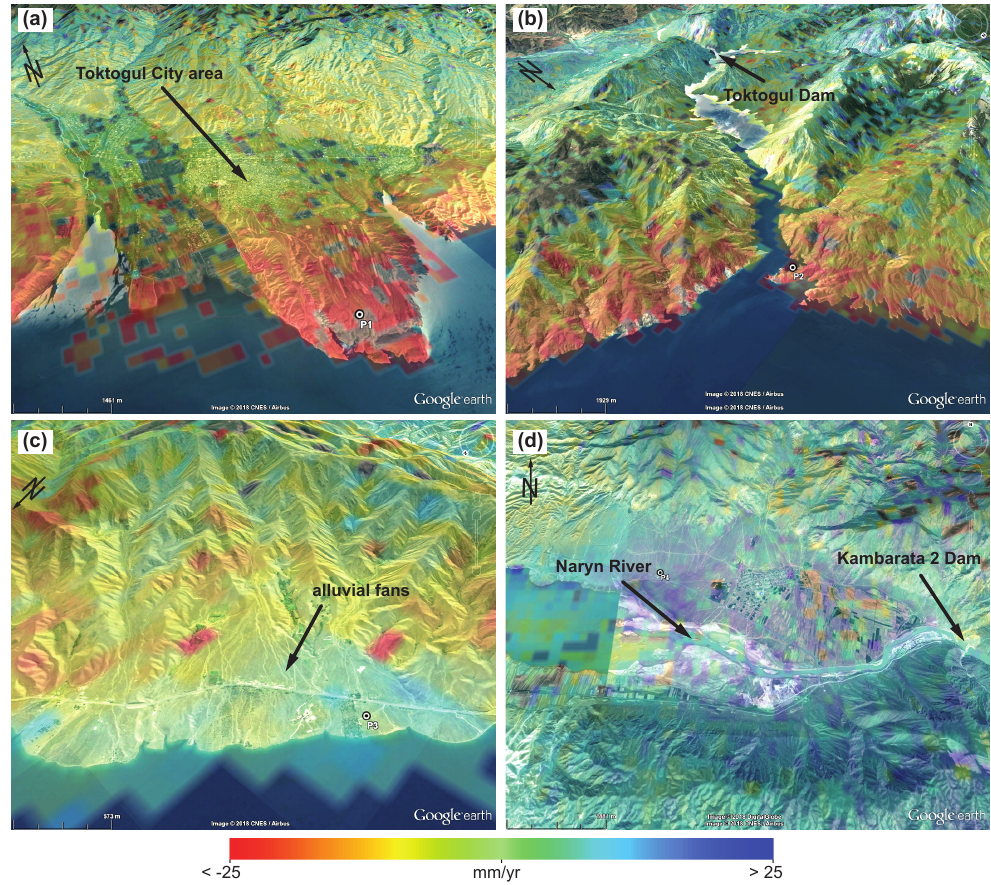
Figure 9. Vertical deformation extracted from Sentinel-1 decomposition around ( a ) point P1 and the Toktogul city area; ( b ) point P2; ( c ) alluvial fans at point P3 and ( d ) the Naryn River entrance area at point P4. For the locations of the points (refer to Figure6). Background imagery provided by Google ®